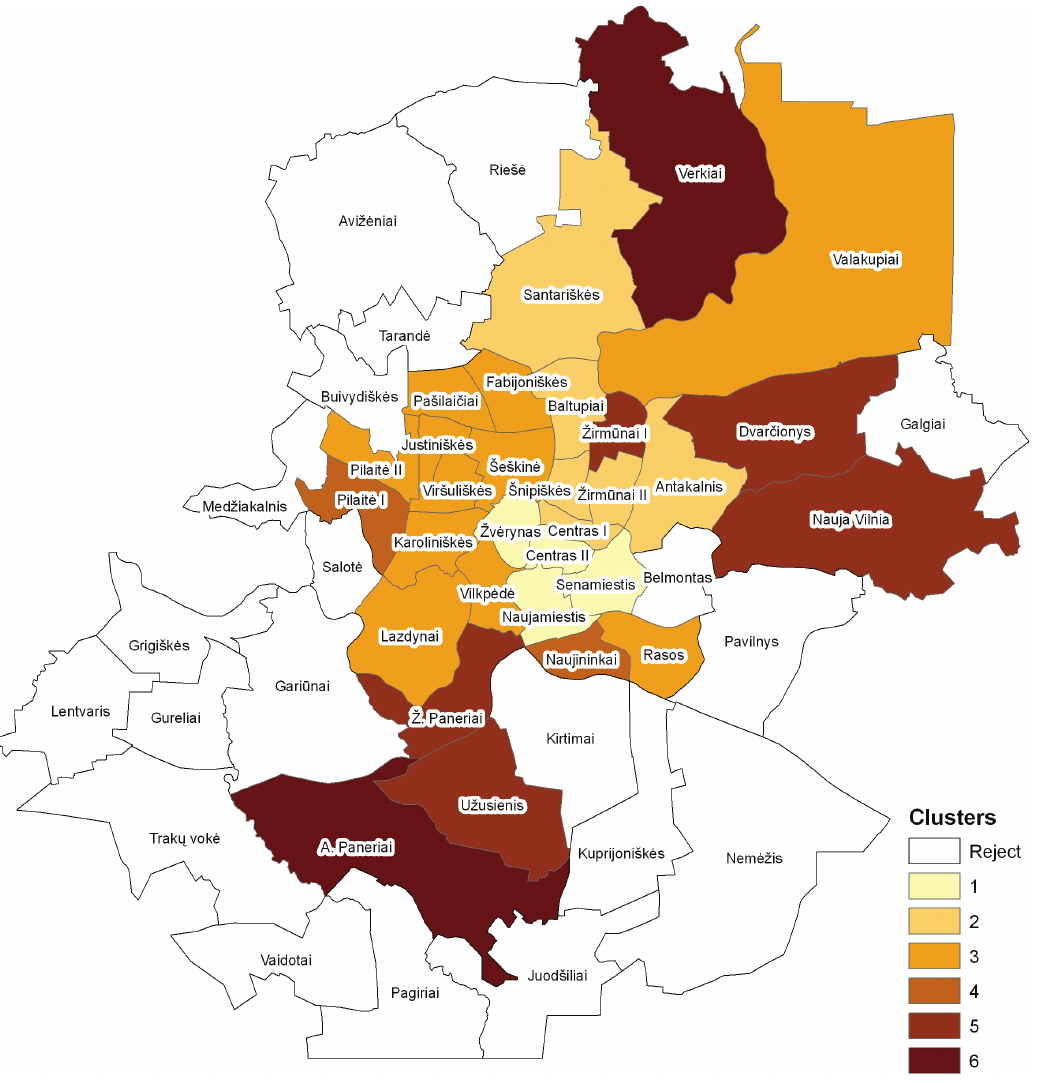
figure 5. Vilnius districts grouped in six